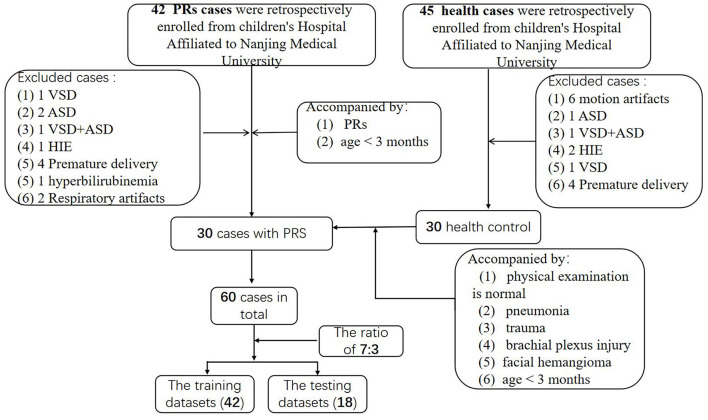
Flow diagram of enrolled patients. HIE, neonatal hypoxic-ischemic encephalopathy; VSD, ventricular septal defect; ASD, atrial septal defect.